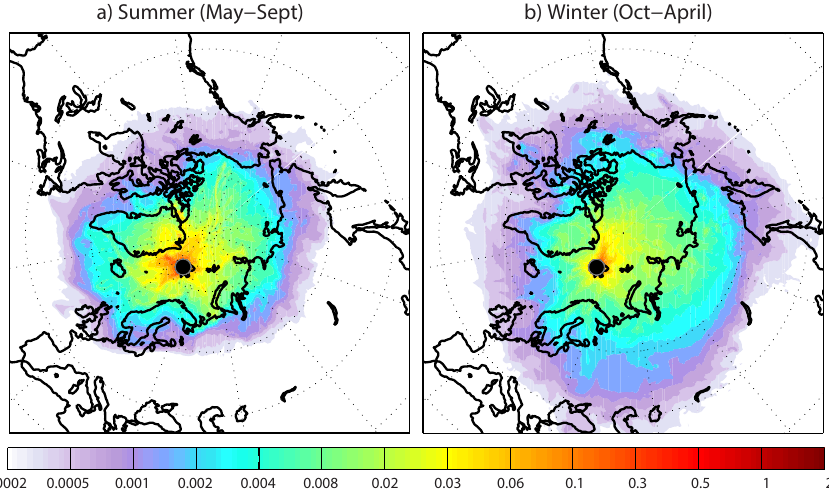
Figure 3. The overall emission sensitivity of measurements at the Zeppelin observatory to surface emissions during the last 30 days of air transport to the site for summer (here: mean of June–August, 2008) (a) and winter (here: mean of January–March, 2009) (b) , respectively. Unit: nsm − 3